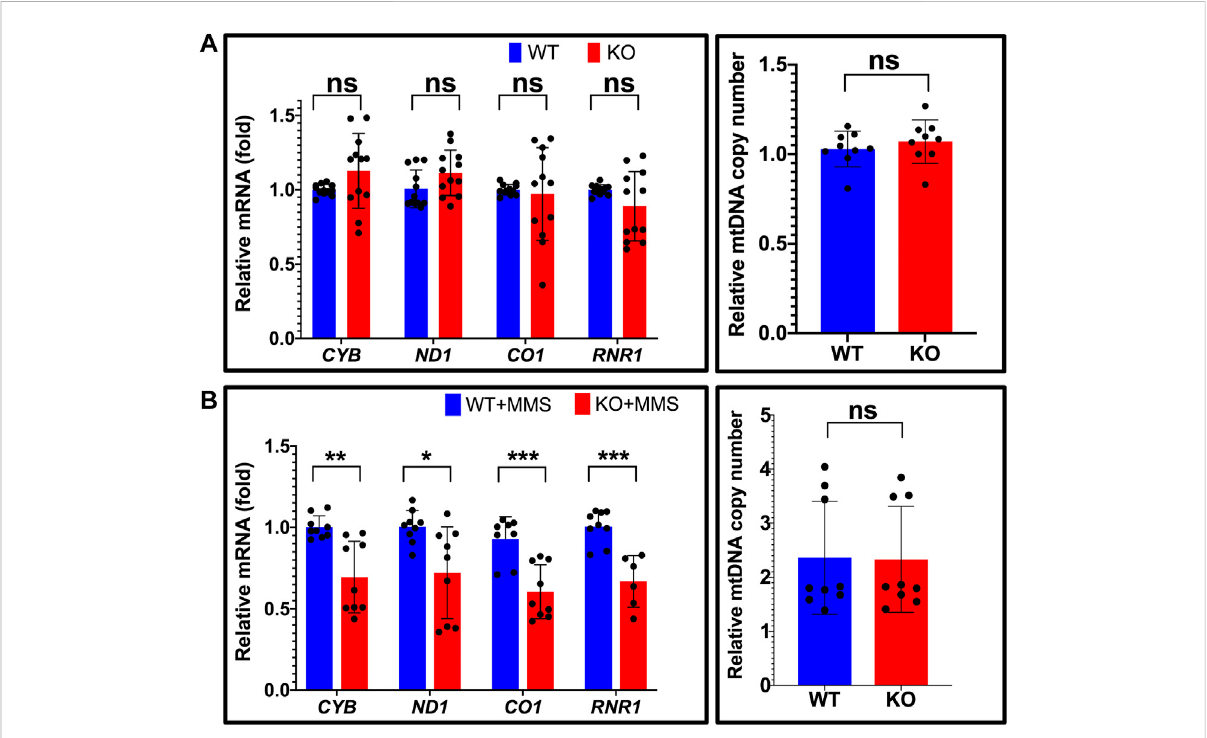
FIGURE 10 EstimationofrelativemitochondrialmRNA expression revealsthat NEIL1isnecessaryforef fi cienttranscriptionbyTFAMuponDNAdamage. (A) Left,therelativemRNAexpressionoffourmitochondrialgenesencodingCytochromeb( CYB ),NADHdehydrogenasesubunit1( ND1 ),Cytochromec oxidaseI( CO1 ),and12SribosomalRNA( RNR1 )wereestimatedbyqRT-PCRinuntreatedHap1celllineswheretheexpressionofNEIL1iseitherintact (i.e., wild-type, WT) or knocked out (i.e., KO). Right, estimation of mitochondrial copy number by qPCR in the WT and KO cell lines. (B) Left, the relative mRNA expression of the above four mitochondrial genes in the WT and KO Hap1 cells treated with 125 μ M MMS for 3 days prior to gene expressionanalysis.Right,estimationofmitochondrialcopynumberbyqPCRintheWTandKOcelllinesafterMMStreatment.Statisticalanalysiswas performed in GraphPad Prism using a Student ’ s t-test where ns, not signi fi cant; * p < 0.05; ** p < 0.01; and *** p <